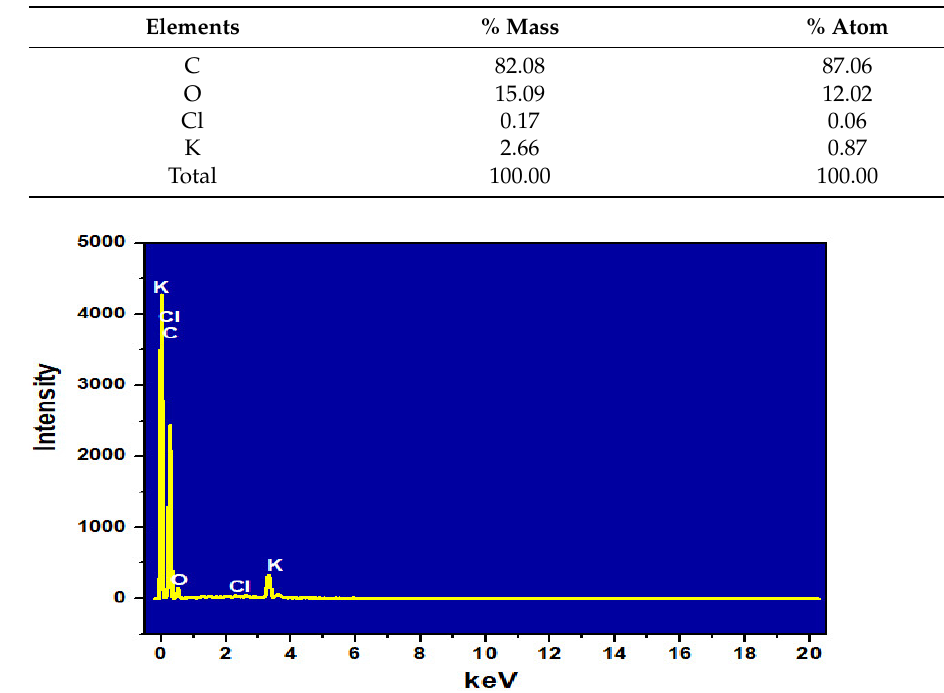
Figure 3. EDS spectrum of ACDS.